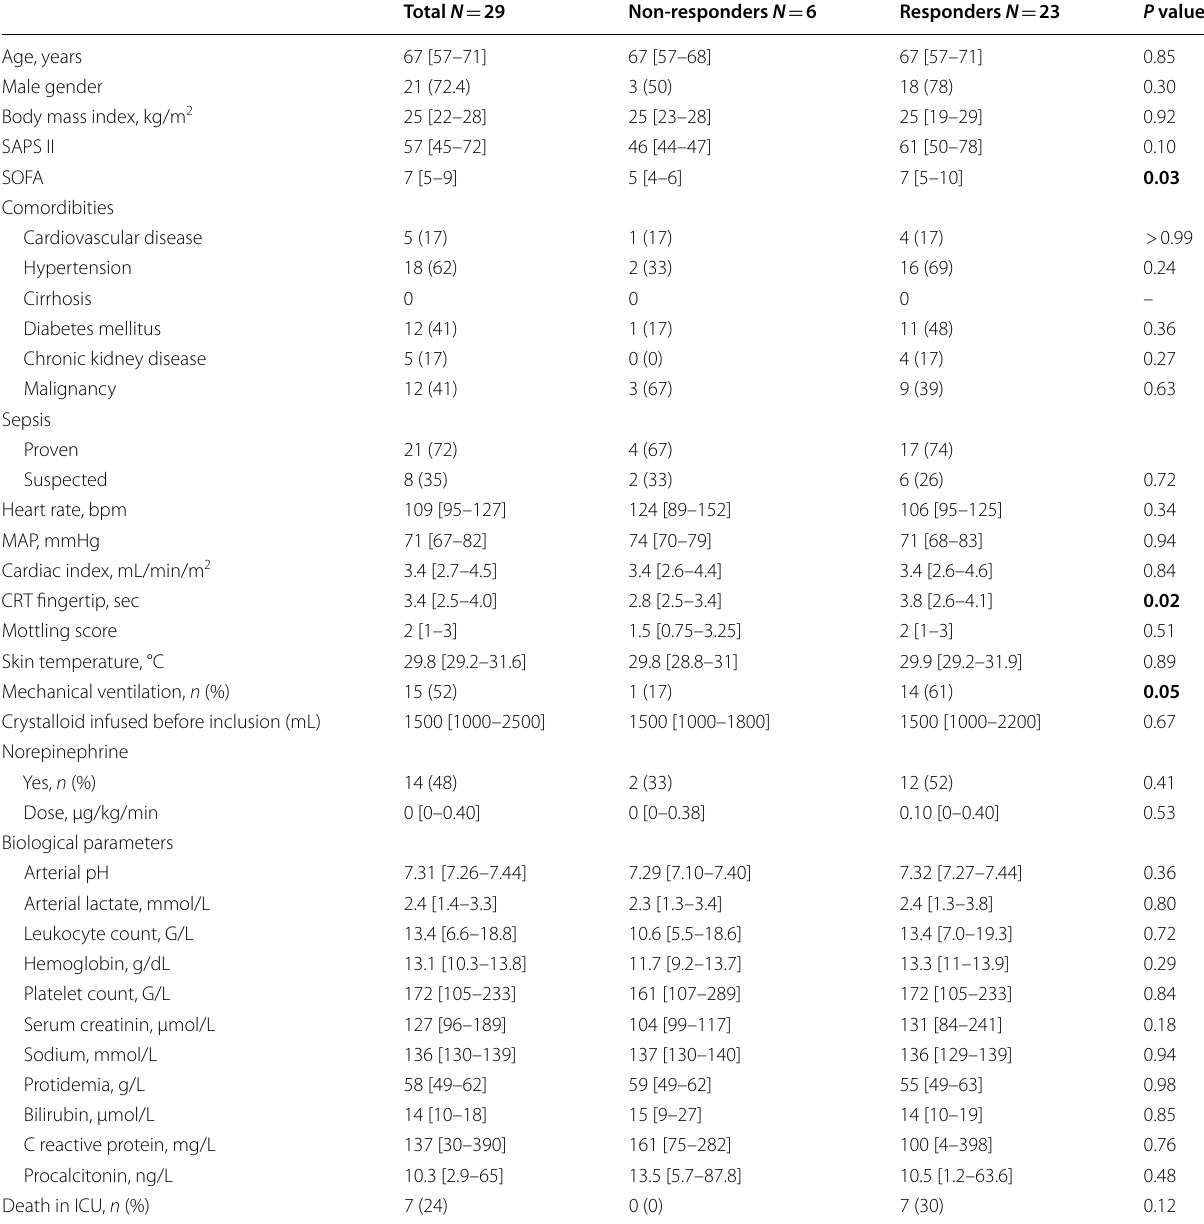
Table 1 Baseline characteristics of studied population. Parameters and SOFA (Sequential Organ Failure Assessment) were reported at